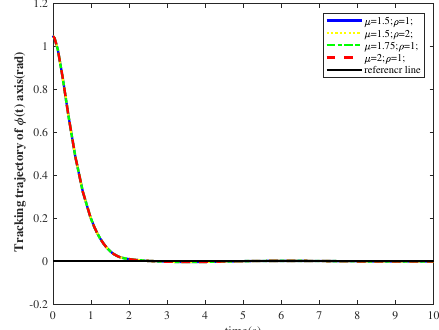
Figure 12. e φ of different µ and ρ .